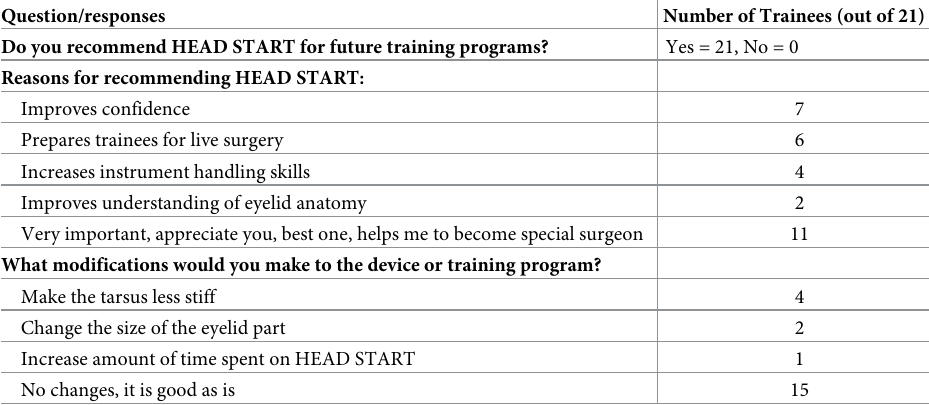
Table 4. Open-ended Trainee